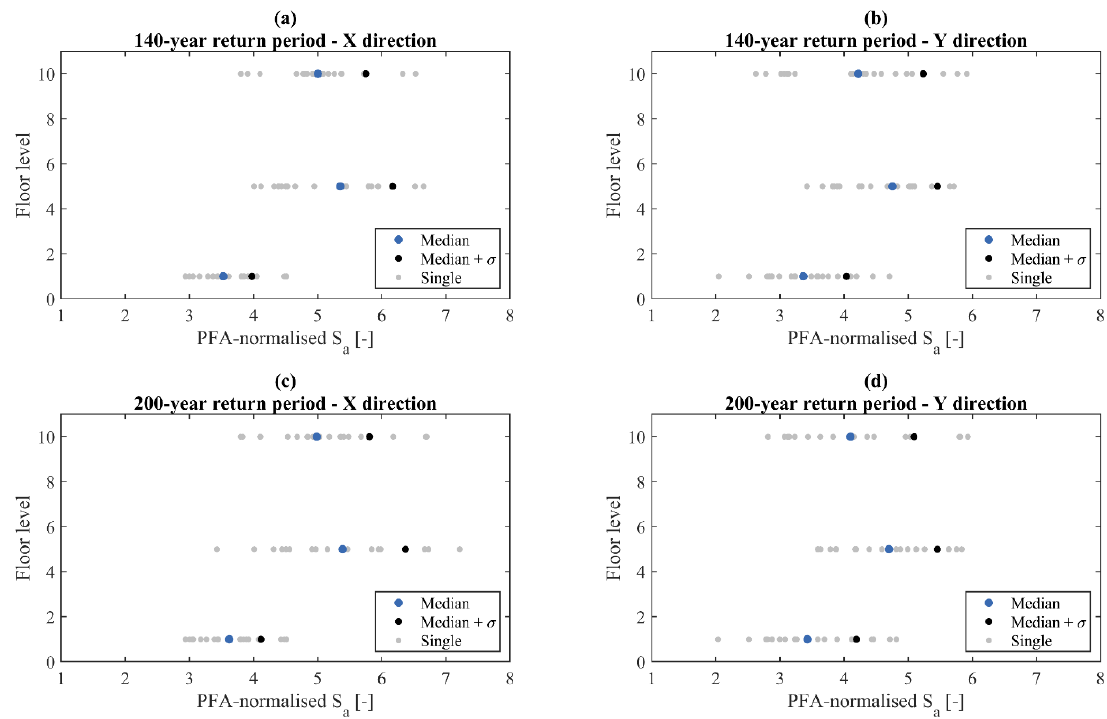
Figure 10. PFA-normalized maximum spectral accelerations over the structure height: ( a ) RP = 140 years, X direction; ( b ) RP = 140 years, Y direction; ( c ) RP = 200 years, X direction; ( d ) RP = 200 years, Y direction.